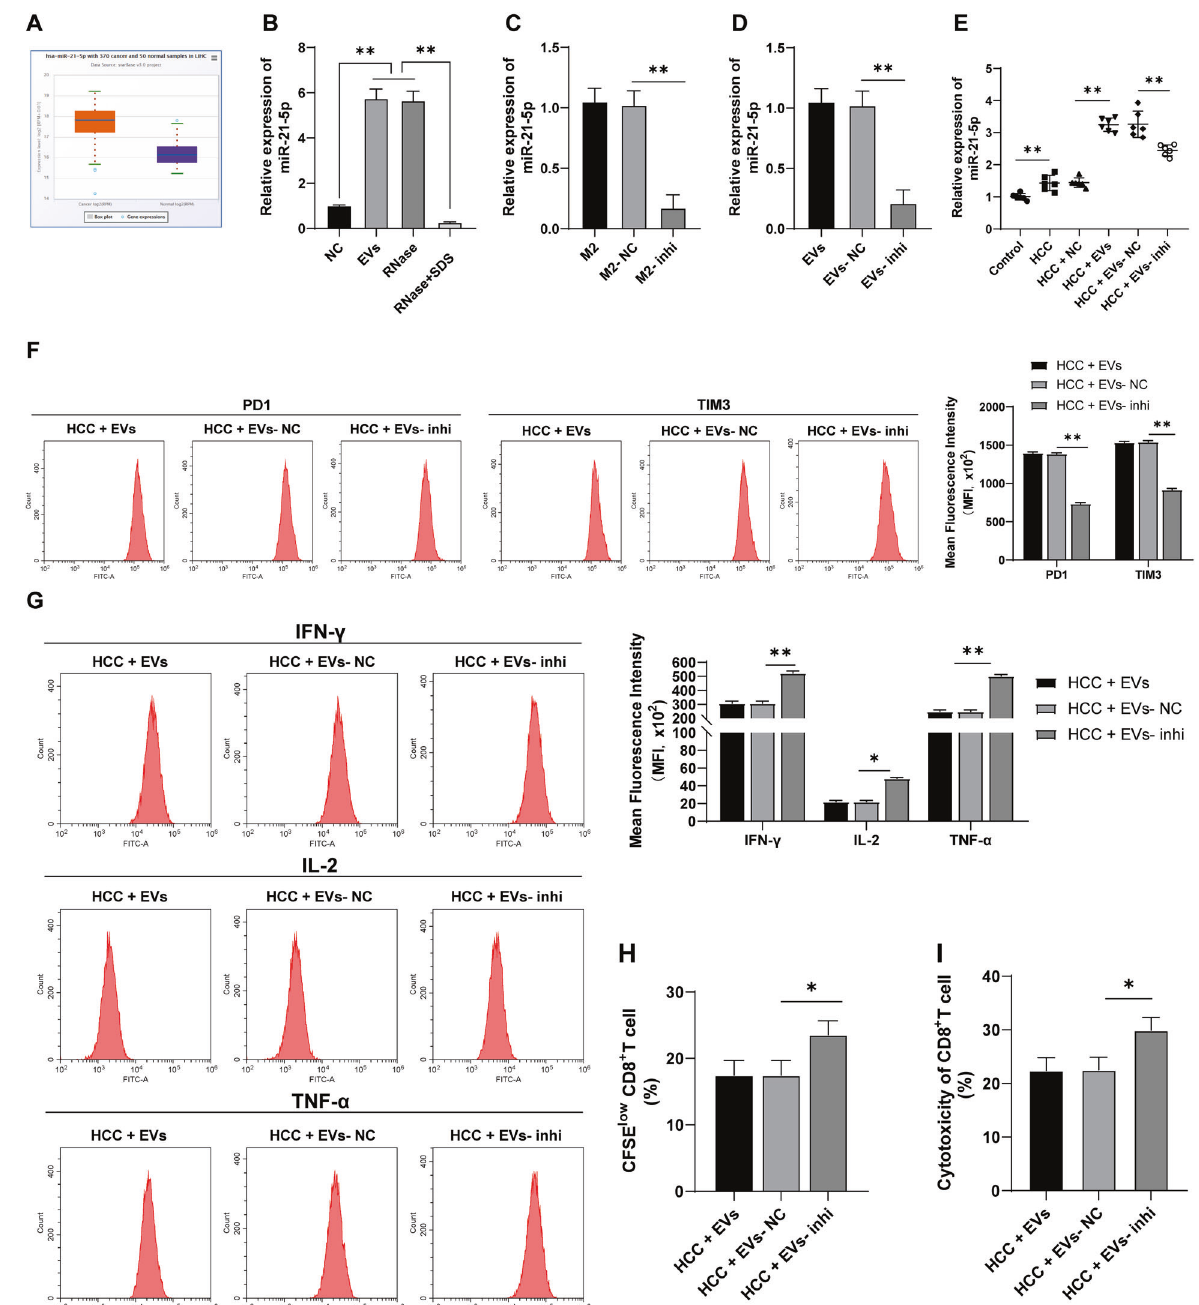
Fig. 2 EVs carried miR-21-5p into the liver tissues of mice. A miR-21-5p expression in HCC was analyzed through the ECORI Pan-Cer database. B miR-21-5p expression in EVs under different treatments was detected using RT-qPCR. M2 macrophages were transfected with miR-21-5p inhibitor. C , D miR-21-5p expression in M2 macrophages and M2 macrophage-derived EVs was detected using RT-qPCR. E HCC mice were injected with EVs under different treatments and the mice were killed after 20 days to obtain liver tissues, and miR-21-5p expression in mouse liver tissues was detected using RT-qPCR. PBMCs were isolated from the mouse liver and CD8 + T cells were sorted. F The expressions of PD1 and TIM3 on CD8 + T cell surface were detected using fl ow cytometry. G The expressions of effector cytokines (IFN- γ , IL-2, and TNF- α ) were detected using fl ow cytometry. H The proliferation ability of CD8 + T cells was measured using fl ow cytometry. I The ability of CD8 + T cells to kill Hep1-6 cells was measured using fl ow cytometry. N = 6. The cell experiment was repeated 3 times. Data are presented as mean ± standard deviation and analyzed using one-way ANOVA, followed by Tukey ’ s multiple comparison test, * p < 0.05, ** p <